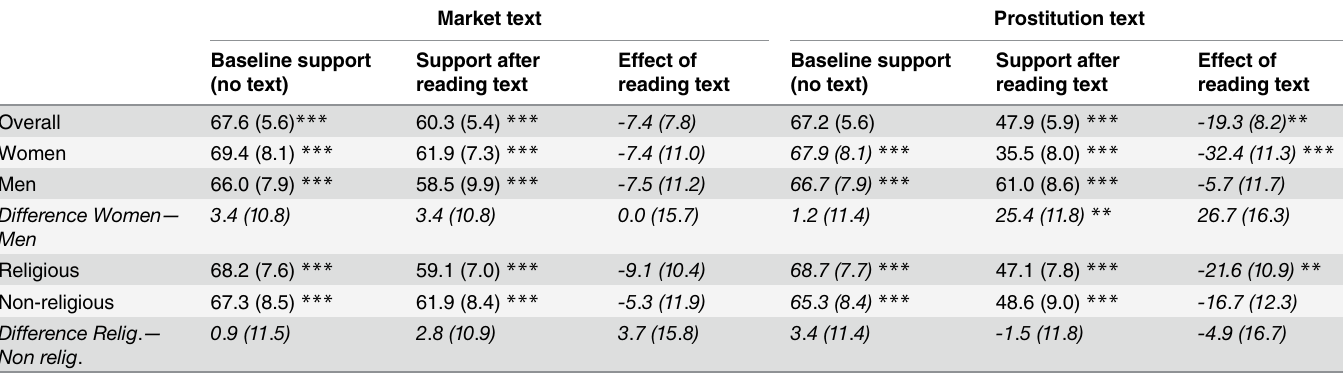
Table 5. Regression estimates, heterogeneous effects: Support for legalizing organ